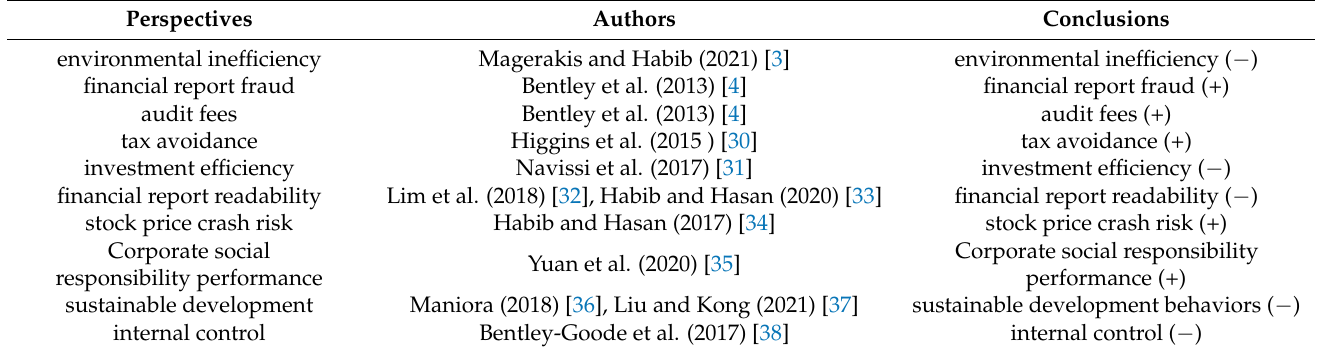
Table 1. Summary of main research conclusions on economic consequences of business